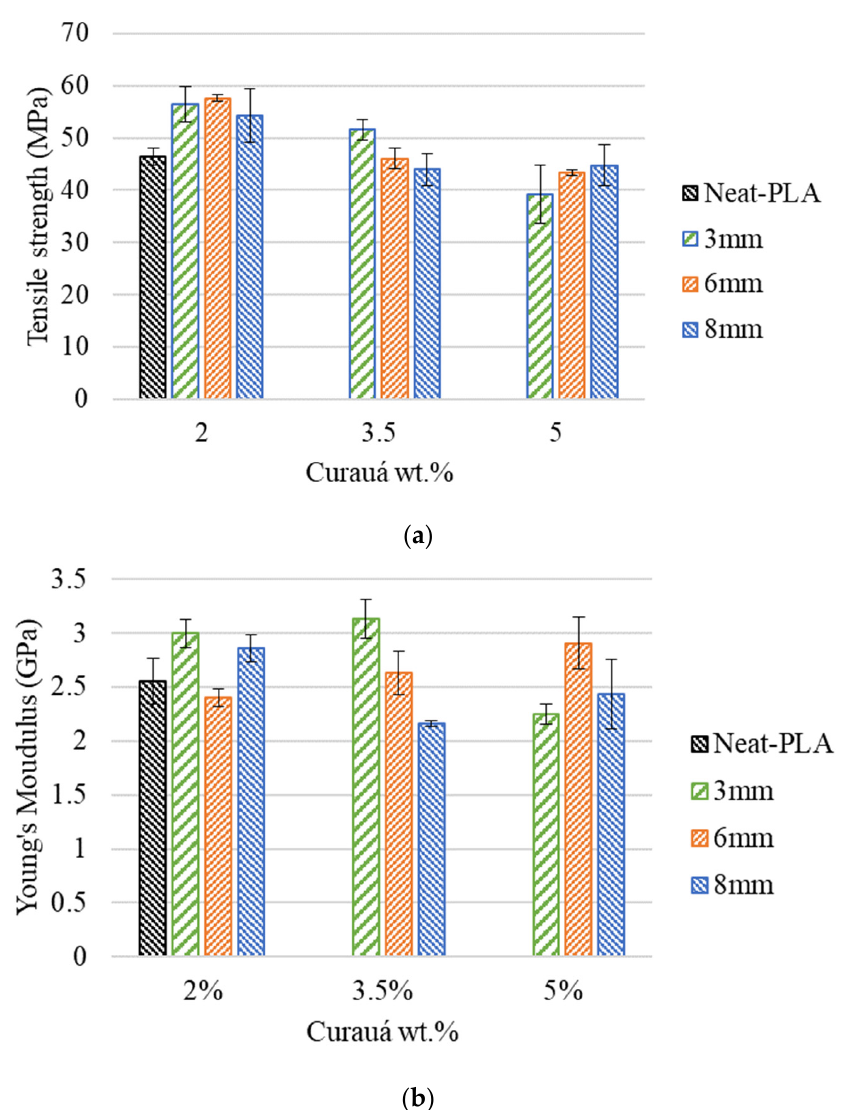
Figure 6. Representative tensile stress–strain curves.